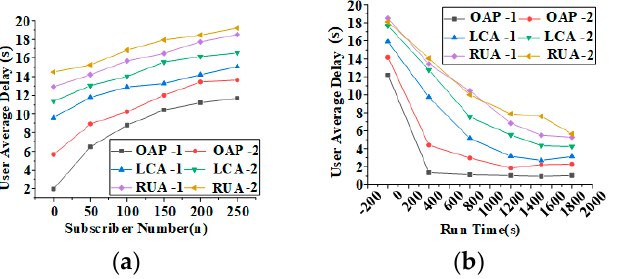
Figure 9. Influence of the number of users and the system running time on the average user delay ( a ) curves of the average user delay with user number; ( b ) curve of the average user delay with the system running time.